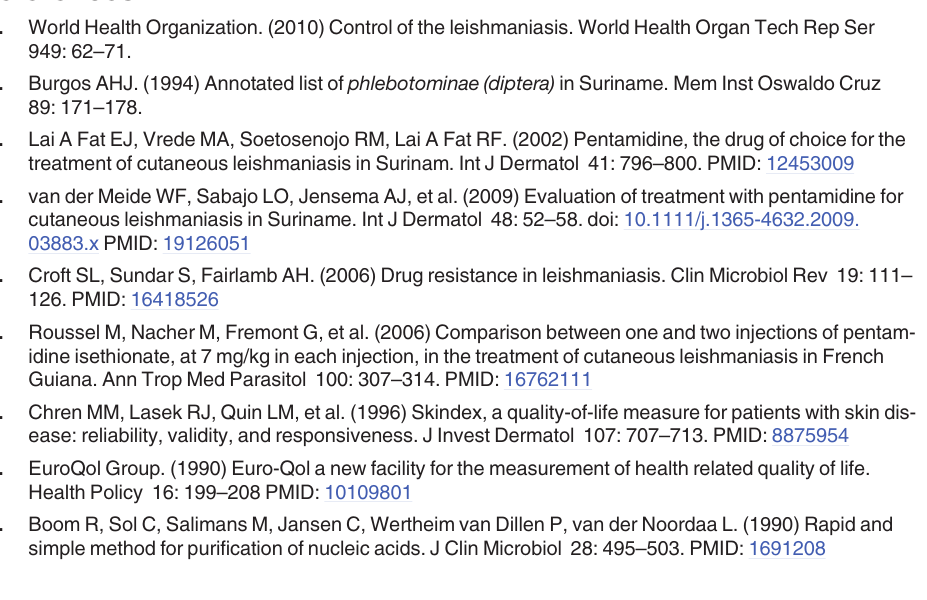
S1 Table. Sensitivity analyses of Safety data. Adverse events 1 week after treatment according to treatment group of cutaneous leishmaniasis patients in Suriname from 2010 – 2013. S2 Table. Sensitivity analyses of clinical laboratory values at follow-up 1 week after last treatment according to treatment group of cutaneous leishmaniasis patients in Suriname from 2010 –